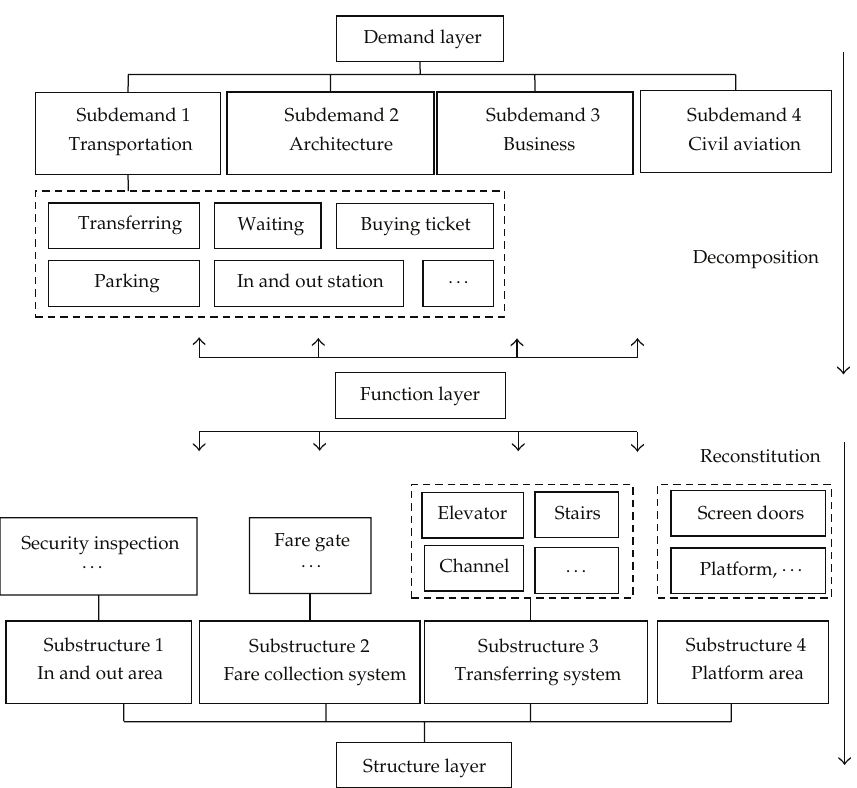
Figure 2: Decomposition and reconstitution of transportation concept layout model.